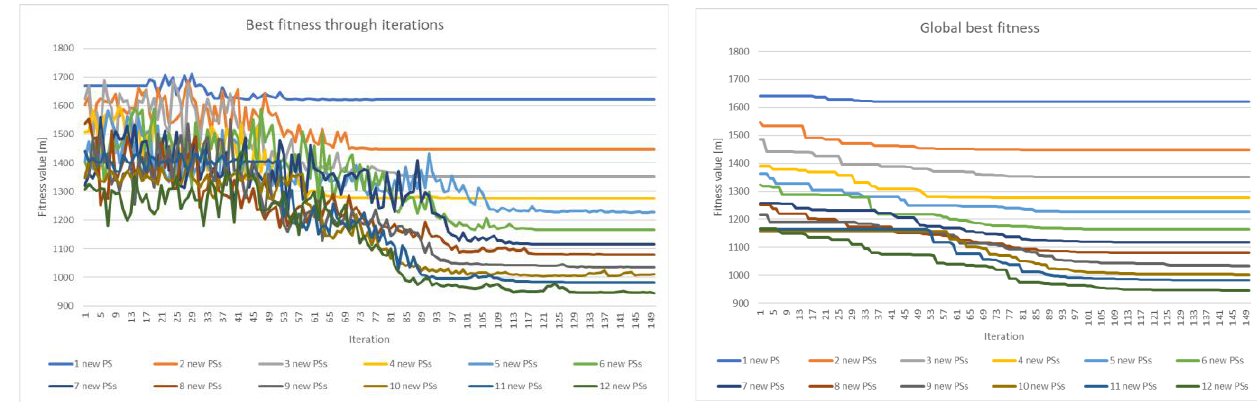
23 of 26 Figure 27. Best fitness through iterations and the global best fitness: eleven new PSs. Finally, the position of the new PSs is compared with the areas already investigated by Unareti for the location of the PSs included in the developing plan and the existing MV substations. The new PS called “ 3 ” is not far away from the MV substation “ SV ” ; the new PS called “ 6 ” from the MV substation “ CR ” ; the new PS called “ 9 ” from the MV substation “ PO ” ; the new PS called “ 10 ” from the MV substation “ MU ” . Thus, the methodology pro- poses to revamp them to take advantage of using the existing space.